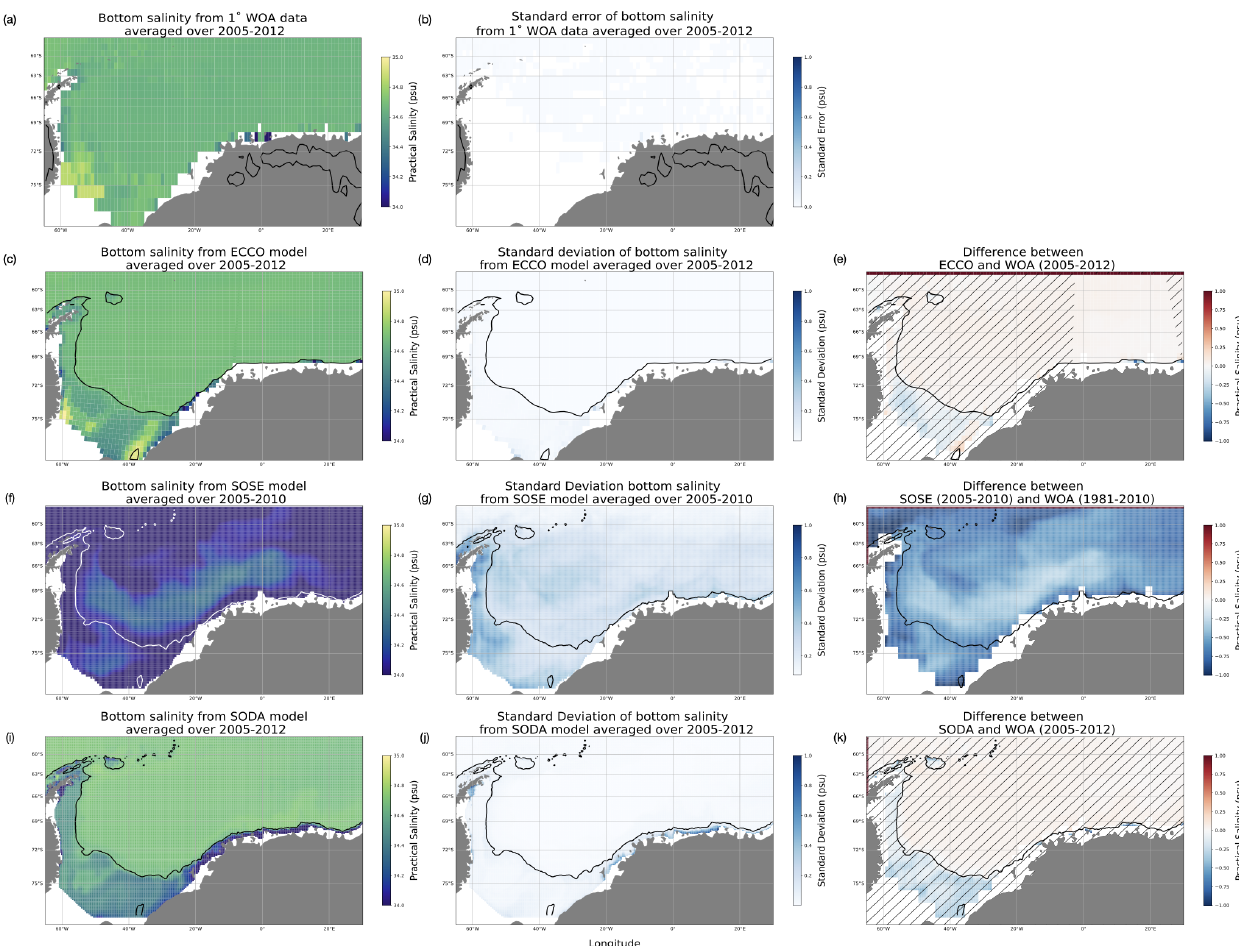
Figure 2. Annual mean of bottom salinity (psu) of the Weddell Gyre region for (a) WOA (2005–2012), (c) ECCO (2005–2012), (f) SOSE (2005–2010) and (i) SODA (2005–2012). Standard error of WOA observations is shown in (b) ; temporal standard deviations are shown for (d) ECCO, (g) SOSE and (j) SODA. The differences between the observed and simulated bottom salinities are shown in (e) ECCO, (h) SOSE and (k) SODA. Black hatching denotes the areas where the difference between model and WOA is less than the observation’s standard error. The black contour represents the 1000m